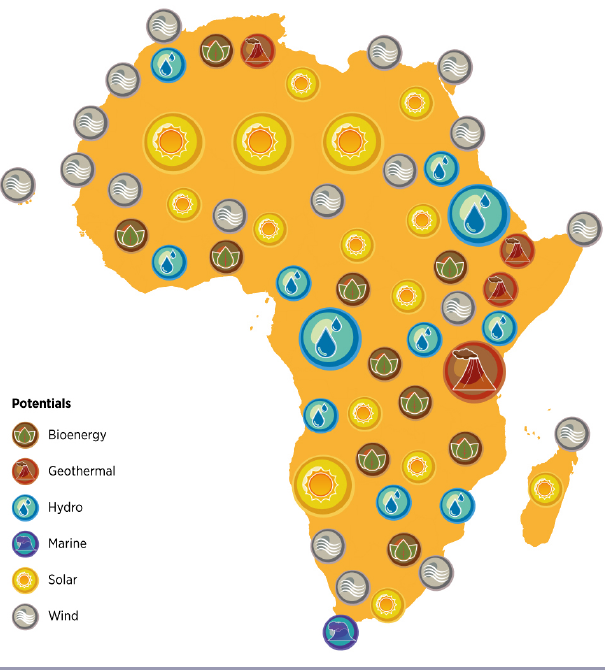
Fig. 4 . Distribution of identified renewable energy potential in Africa. Source: International Renewable Energy Agency (2013), based on the Global